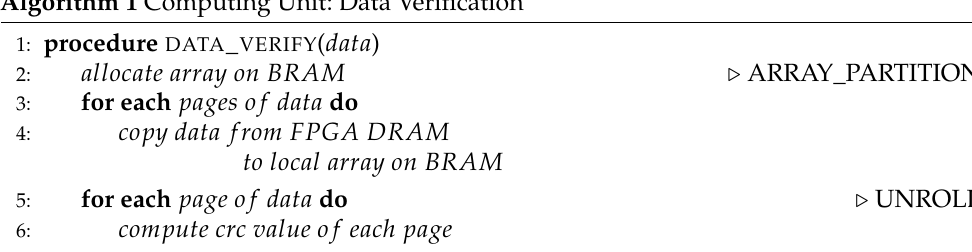
Algorithm 1 Computing Unit: Data